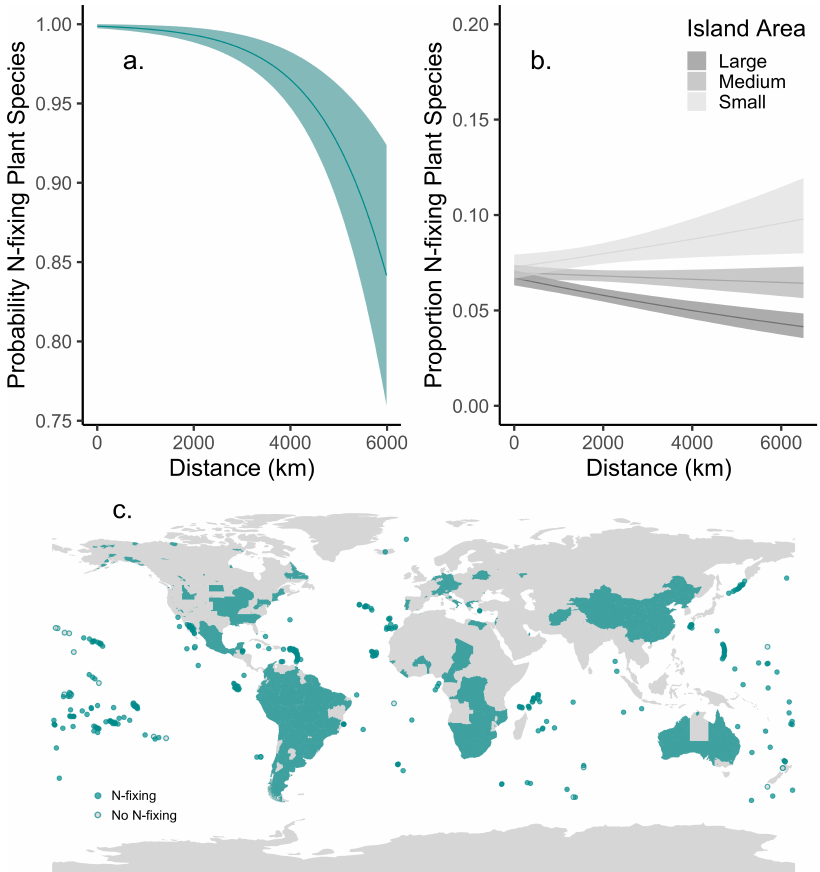
Fig. 2 The probability of N- fi xing plant species occurrence on oceanic islands decreases with island isolation, while the proportion depends on island area. The probability that N- fi xing plant species arrive to oceanic islands decreases with distance from the nearest mainland for all vascular species (GLM, a , p < 0.001, N = 326). The proportion of N- fi xing plant species on these islands decreases with distance from mainland only for large, but not small islands (GLM, b , p < 0.001, N = 288; lines represent small (mean − 1 SD), medium (mean) and large (mean + 1 SD) islands). Con fi dence bands represent 95% con fi dence intervals. Map of presence of N- fi xing plant species globally (C), with fi lled circles indicating locations with N- fi xing plant species present, while empty circles those without N- fi xing plant proportion of N- fi xing plant species declines with distance from the mainland for large and medium oceanic islands, but not for small islands (Fig. 2b, p < 0.001, Supplementary Table 3).